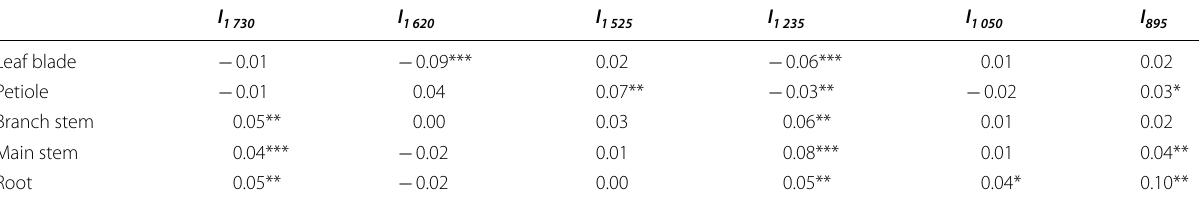
Table 3 Change in average (n 4) of six IR intensity values of cotton plant organs and tissue between the reproductive stage and the = maturation stage and also their difference statistically